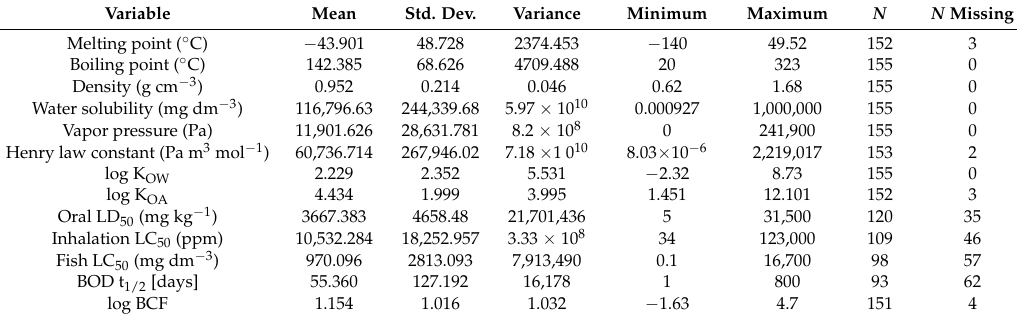
Table 1. Basic statistics of the